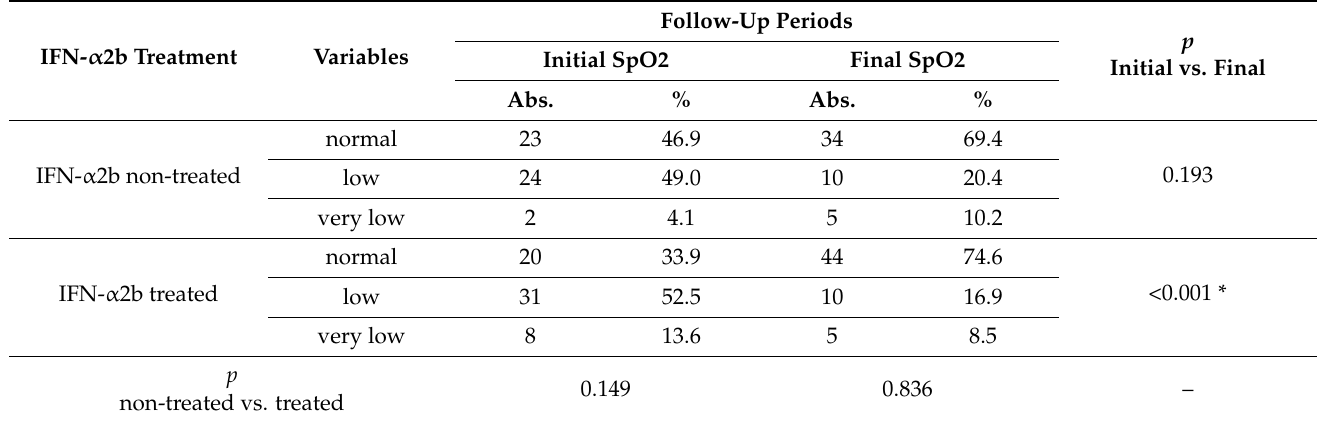
Figure 3. SpO2 dynamics before and after control (dark gray) and IFN- α 2b treatment (light gray) ( A ) and SpO2 relative frequency before and after control and IFN- α 2b treatment ( B ). Table 3. Analysis of the level of SpO2 before and after IFN- α 2b IFN-α2b treatment significantly increased the level of leukocytes from 4 × 10 9 /L to 6 × 10 9 /L ( p = 0.028, Figure 4), but not that of any other blood cell types.